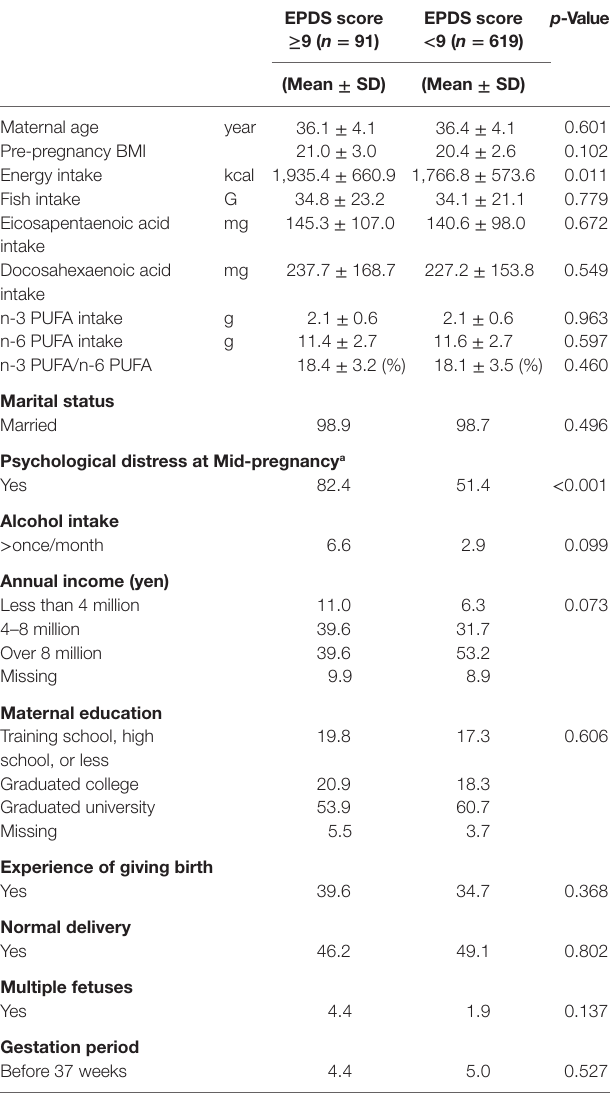
TaBle 2 | Characteristics of participants with and without depression [Edinburgh Postnatal Depression Scale (EPDS) score ≥ 9] at 6 months after